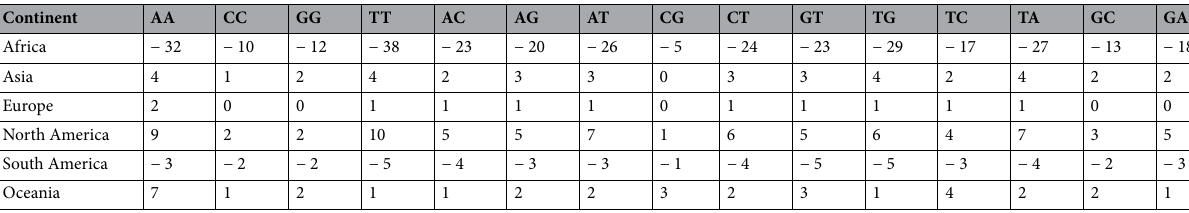
Table 2. Observed average dinucleotide transitions variants between male and female